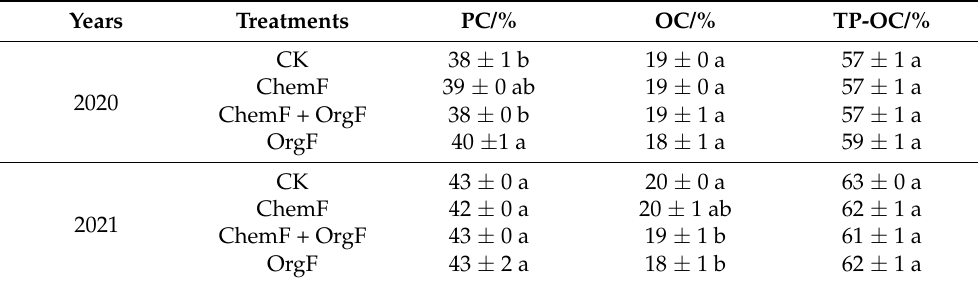
Table 1. The changes in protein content (PC), oil content (OC) and total protein–oil content (TP-OC) in soybean undergoing four treatments in 2020 and 2021. Different letters in the same column indicate significant differences at p = 0.05.